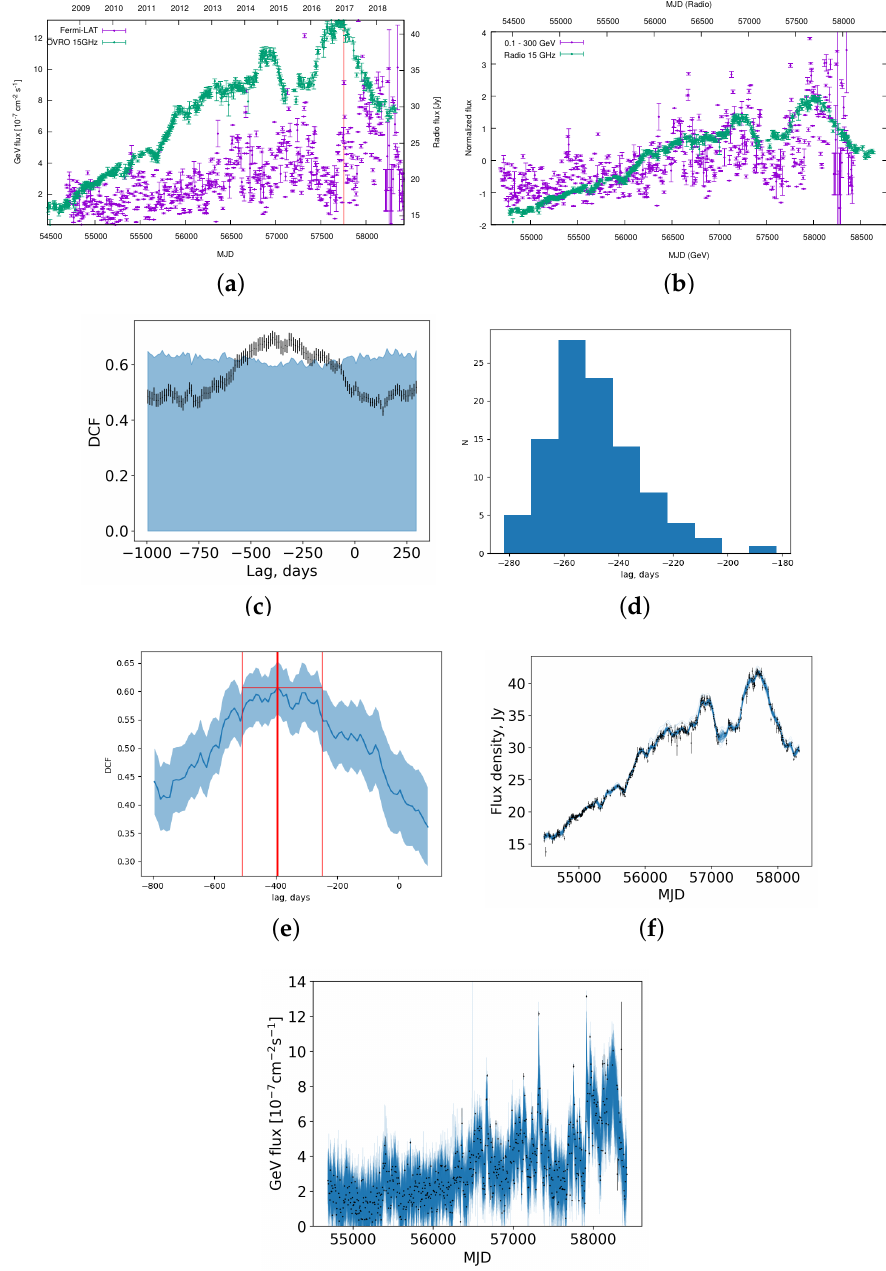
Figure 10. ( a ) OVRO monitoring data (green) and gamma-ray data from the Fermi satellite (violet). The red vertical line marks the time of the TeV flare [30]. ( b ) Superposition of the OVRO and Fermi data (mean-subtracted and time-shifted). ( c ) Significance analysis of the DCF results. The blue shaded region corresponds to a range of the possible DCF-peaks that occur due to a chance at 3 σ level. It was obtained using realizations of the noise-like light curves according to [49]. Black points and error bars shows the obtained DCF. ( d ) Distribution of the Cross-Correlation Function (CCF) peaks obtained using realizations of the Gaussian Processes fitted to the radio and gamma data. ( e ) Mean DCF and corresponding simultaneous 68%-confidence band obtained using realizations of the Gaussian processes fitted to the original radio and gamma data sets. Red lines describe the procedure used to obtain the uncertainty of the DCF maximum. ( c – e ) show the results of a correlation analysis (based on the DCF-routine by [48]). ( f,g ) show the realizations of the fitted Gaussian Processes obtained from the posterior distribution of the hyperparameters for radio ( f ) and gamma ( g )